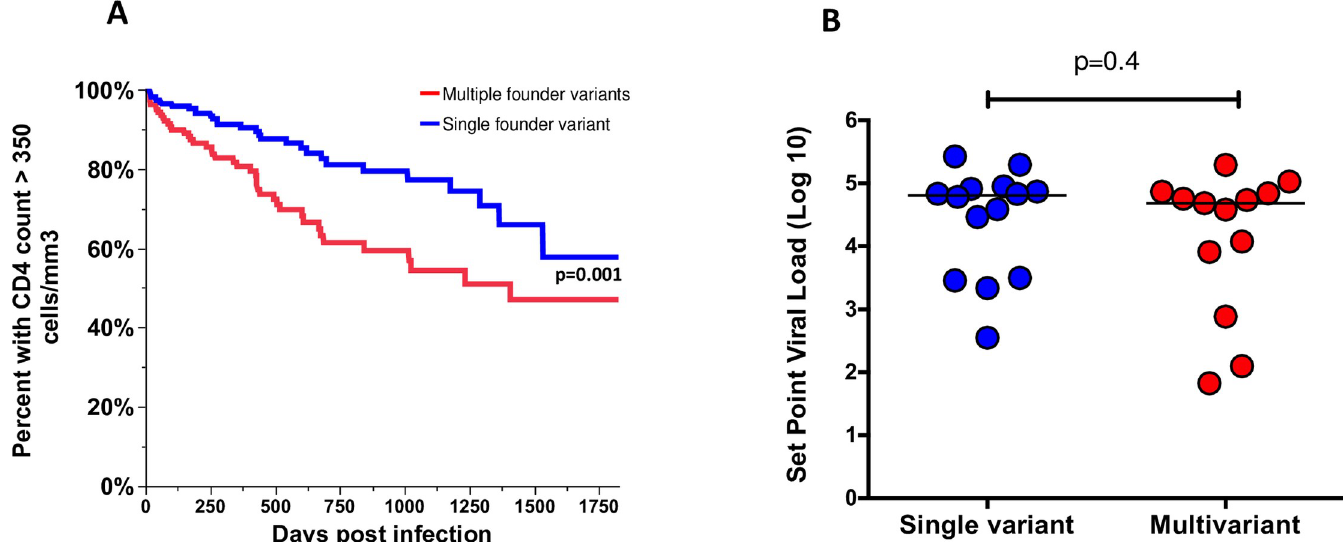
Fig 2. (A) Infection with multiple founder viruses resulted in lower CD4 + T cell counts in the first 5 years of infection with patients infected with multiple founder viruses reaching CD4 + T cell counts under 350 cells/mm 3 faster than those infected with a single variant. B) There were no differences in set point viral